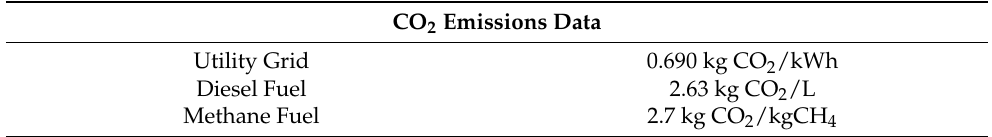
Table 4. The amount of the produced kgCO 2 from utility-grid, diesel fuel and methane fuel, evaluated for the Jordan case.